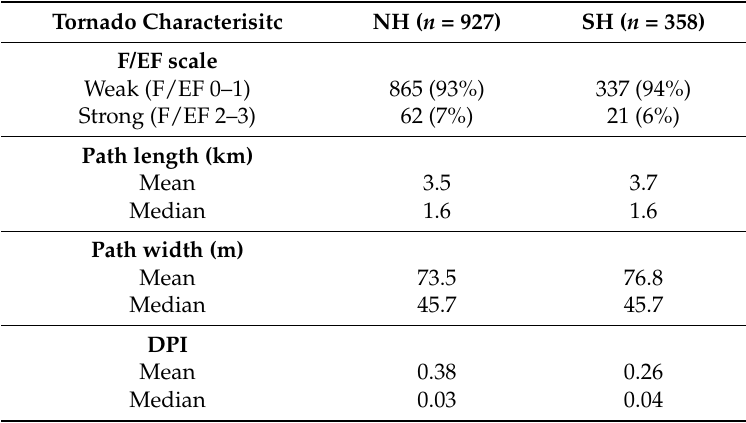
Table 9. Descriptive statistics for the north and south halves (NH and SH,